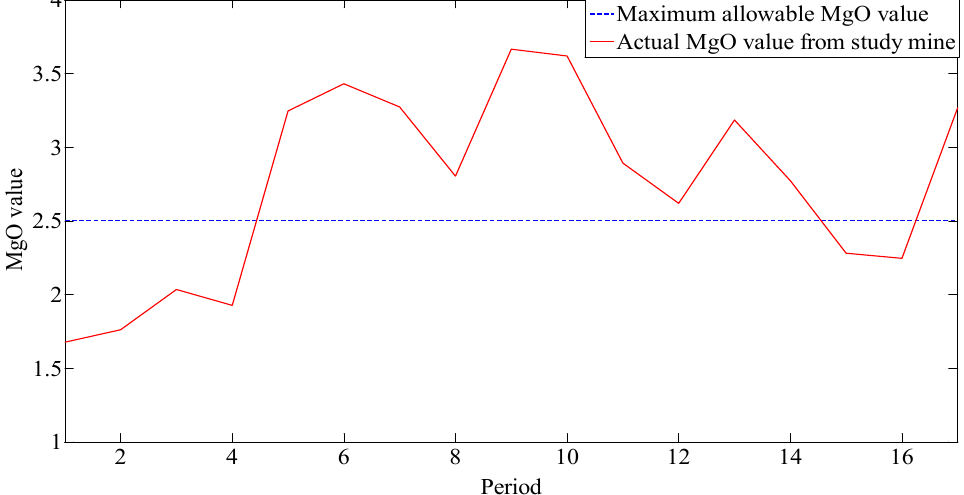
Figure 13. Model 2 MgO value with allowable MgO value for 16 periods.